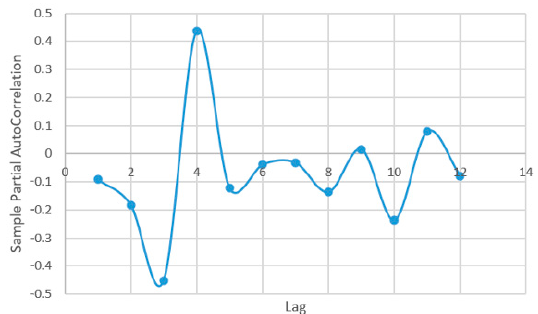
Figure A1. The AC with transformation in square roots—Series A.